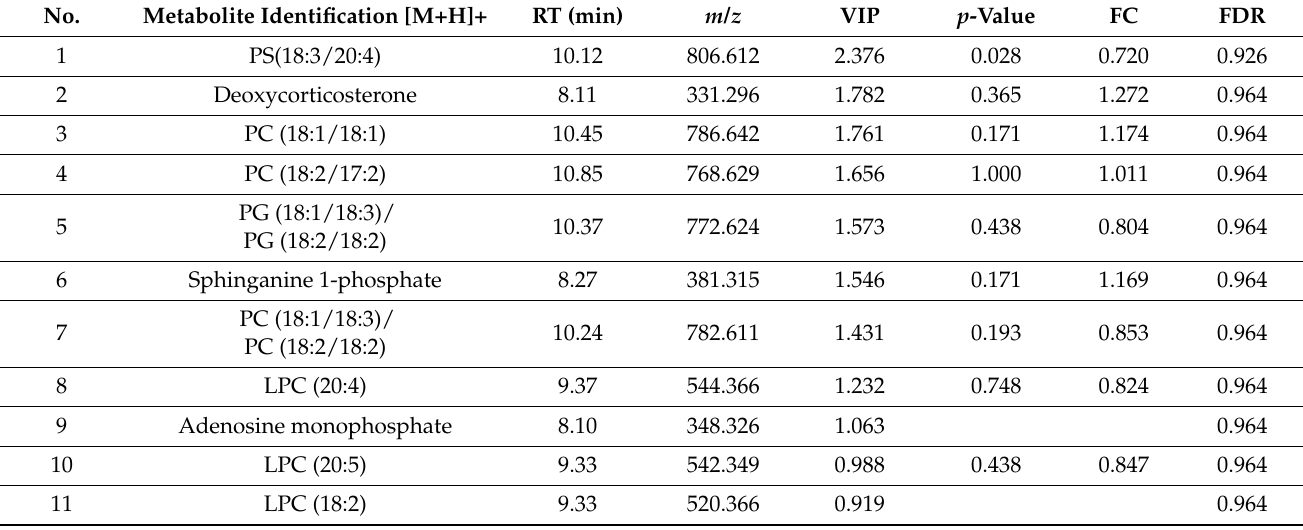
Table 4 mentions the identification of molecules and the VIP, p - and fold change (FC) values.